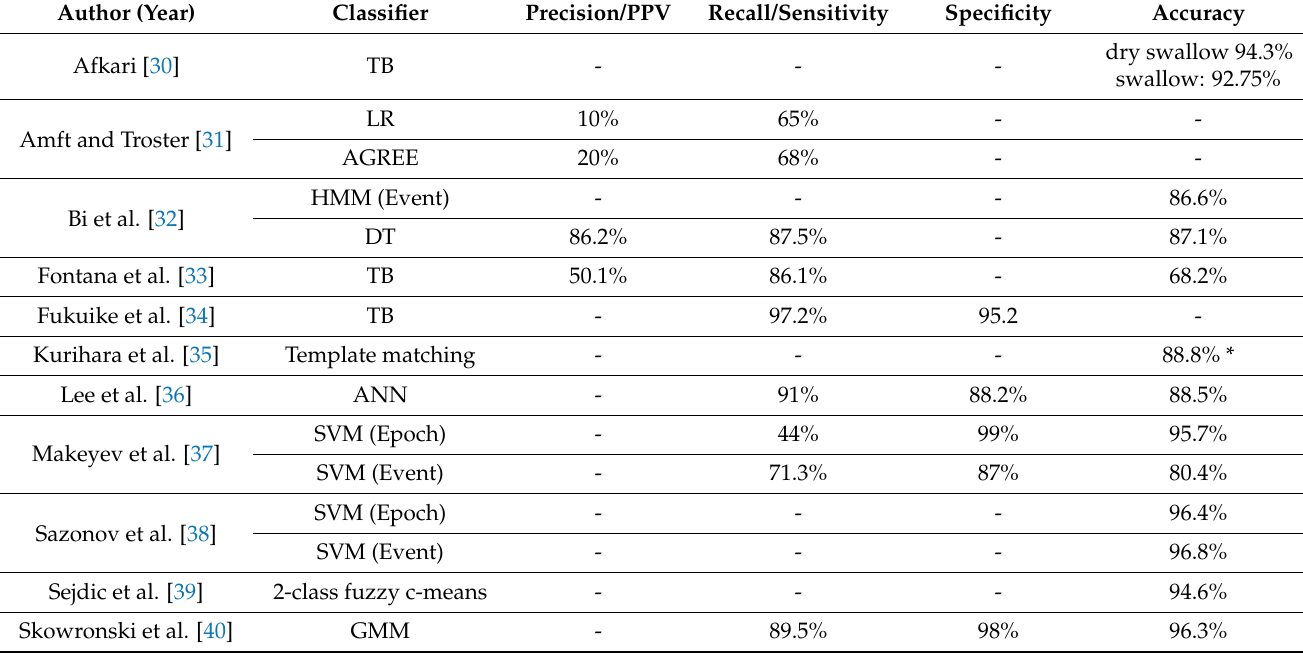
Table 4. Classification performance for swallow detection or